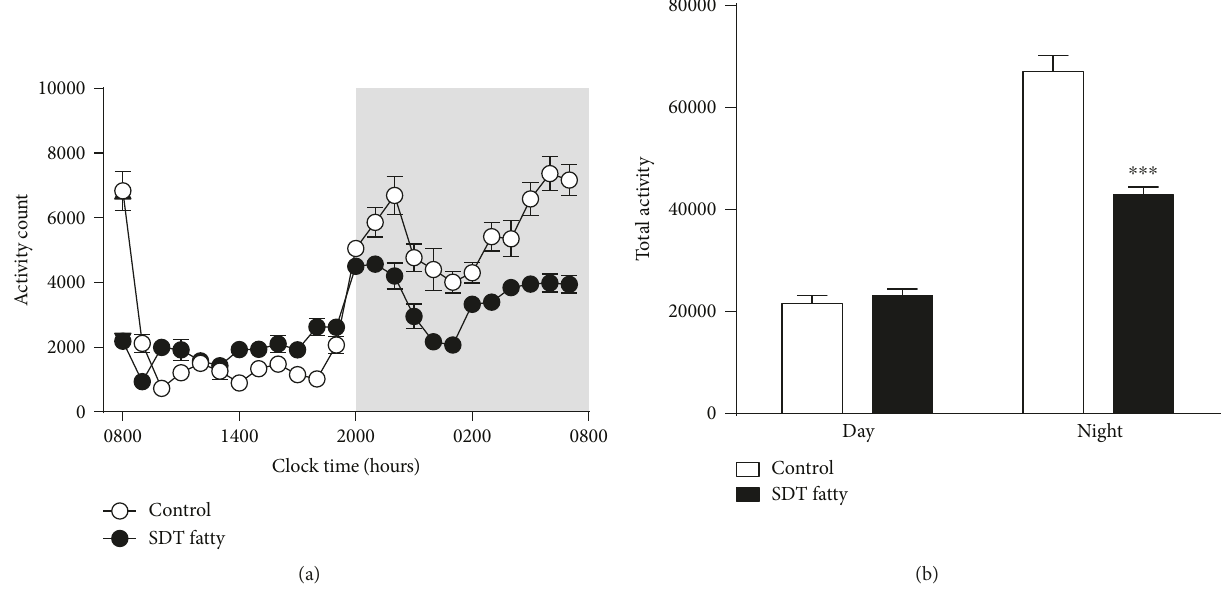
Figure 1: Circadian rhythm of spontaneous locomotor activity (SLA) in control Sprague – Dawley (SD) and Spontaneously Diabetic Torii (SDT) fatty rats. (a) Hourly averages of SLA over a 24h period for 5 consecutive days under a standard light – dark cycle (the shaded area indicates the dark phase). (b) Total activity during the light and dark phases in control SD and SDT fatty rats. Data are mean ± SEM ( n = 8 in each group). ∗∗∗ P < 0 001 compared with control SD rats (Aspin-Welch